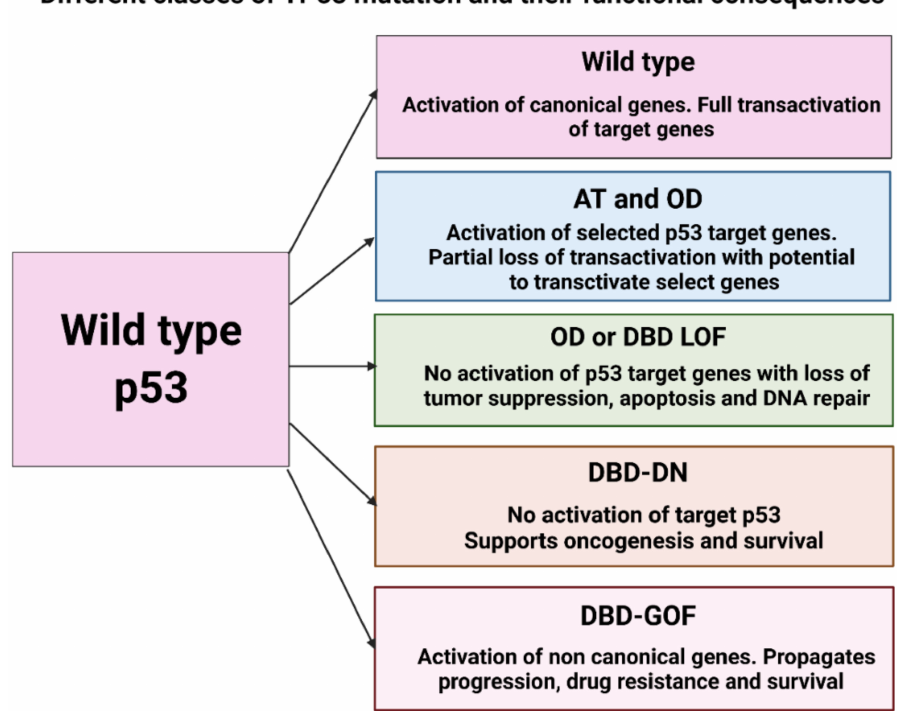
Figure 2. Classes of TP53 mutations and their functional implication. Amino-terminal (AT), Oligomer- ization domain (OD), DNA-binding Domain (DBD), Loss of function (LOF), Double negative (DN), Gain of function